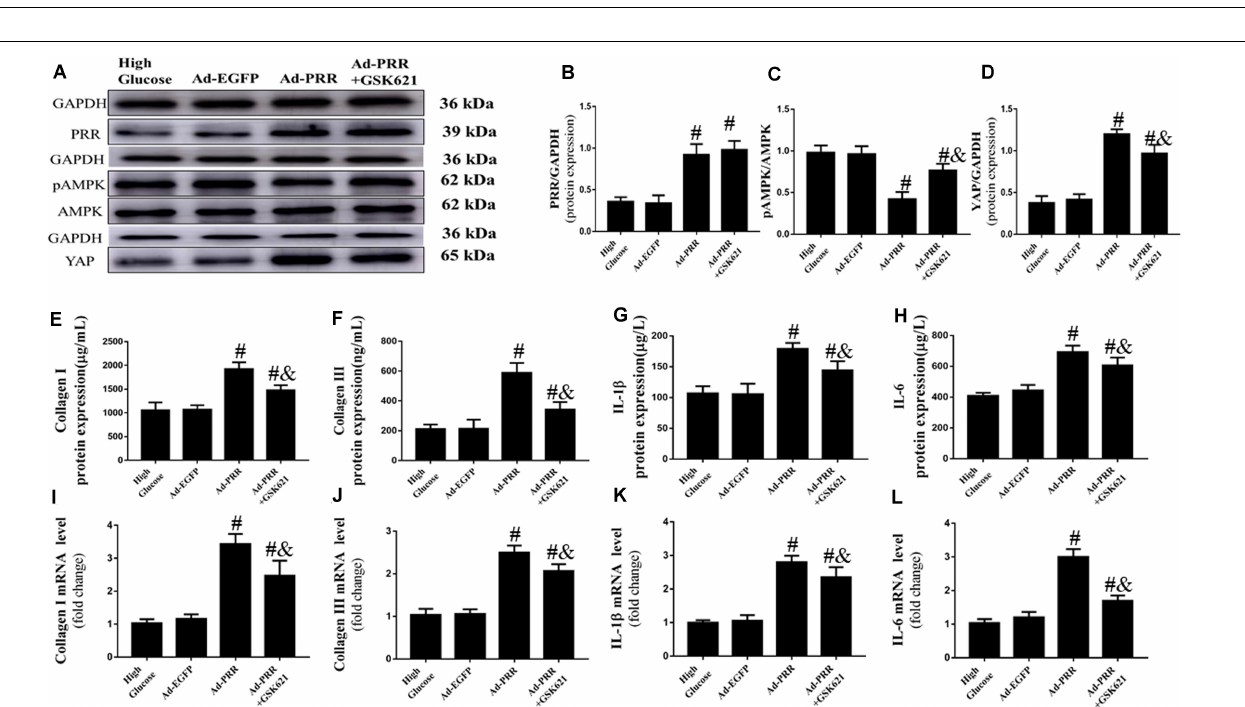
FIGURE 6 | GSK621 increased AMPK phosphorylation and reduced the levels of inflammation and collagen-1 and collagen-3 in neonatal cardiac fibroblasts (CFs) with PRR overexpression ( n = 4). (A) Western blot analysis of PRR, pAMPK, AMPK, and YAP protein expression in the 4 groups. (B) Quantitative analysis of the PRR protein expression shown in panel (A) . (C) Quantitative analysis of the pAMPK/AMPK shown in panel (A) . (D) Quantitative analysis of the YAP protein expression shown in panel (A) . (E–H) ELISA of Collagen I, Collagen III, IL-1 β and IL-6 protein expression in the 4 groups. (I–L) The mRNA expression of Collagen I, Collagen III, IL-1 β and IL-6. # p < 0.05 versus the Ad-EGFP group; & p < 0.05 versus the Ad-PRR group.